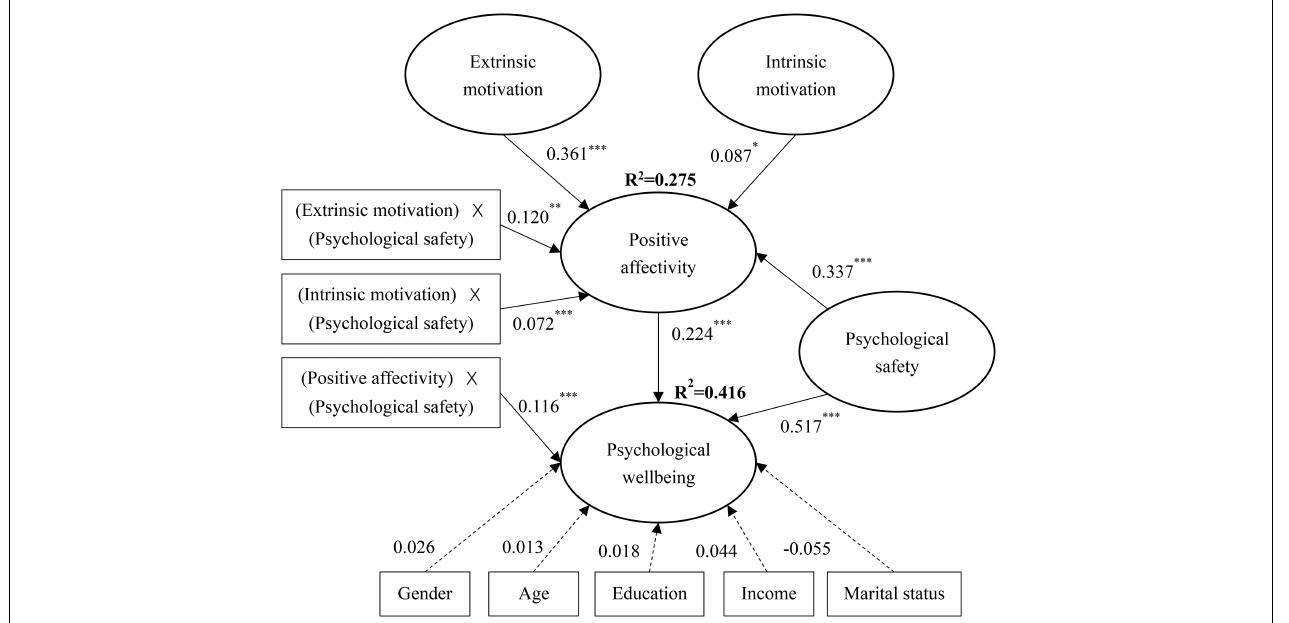
FIGURE 2 | Hypothesis testing. n = 391, ∗ p < 0.05, ∗∗ p < 0.01, ∗∗∗ p <